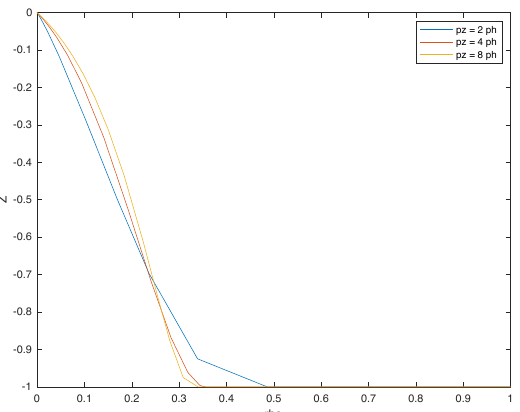
Figure 37. Trajectories in the ( ρ , z ) plane for starting points ( ρ 0 , z 0 ) = ( 1, − 1 ) and considering p z = 2 p h ; p z = 4 p h ; p z = 8 p h . Even at the situation at which the horizontal behaviour is the slowest one there is a faster convergence from ρ 0 to zero than from z 0 to zero as intended.